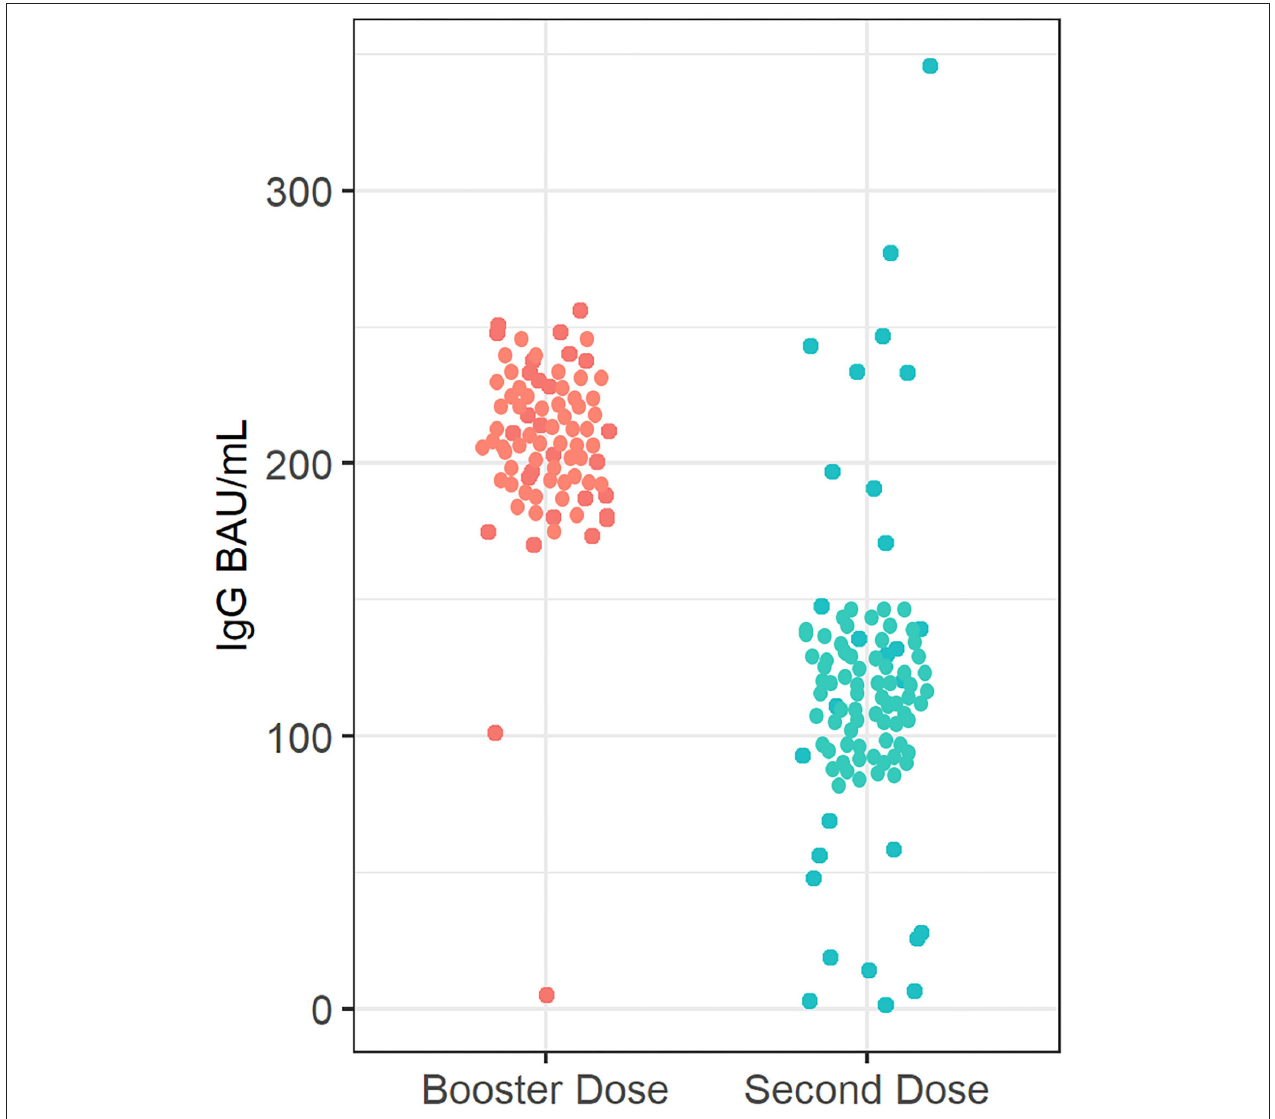
FIGURE 2 | Anti-SARS-CoV-2 -IgG antibody concentrations in patients receiving infliximab combination therapy after the second and third (booster) dose. The median anti-SARS-CoV-2 IgG concentration after receiving the second dose was 125 BAU/ml, whereas the median anti-SARS-CoV-2 -IgG antibody concentration was 207 BAU/ml after receiving the third (booster) dose.